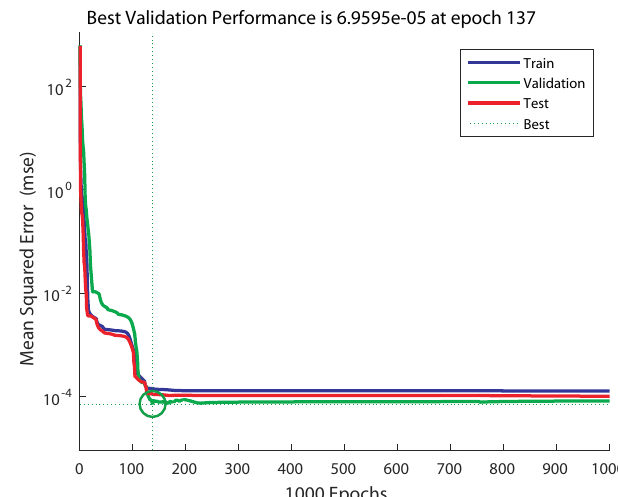
Figure 12. Training performance for a network of 2 × 4 × 4 × 1 (ANN2).